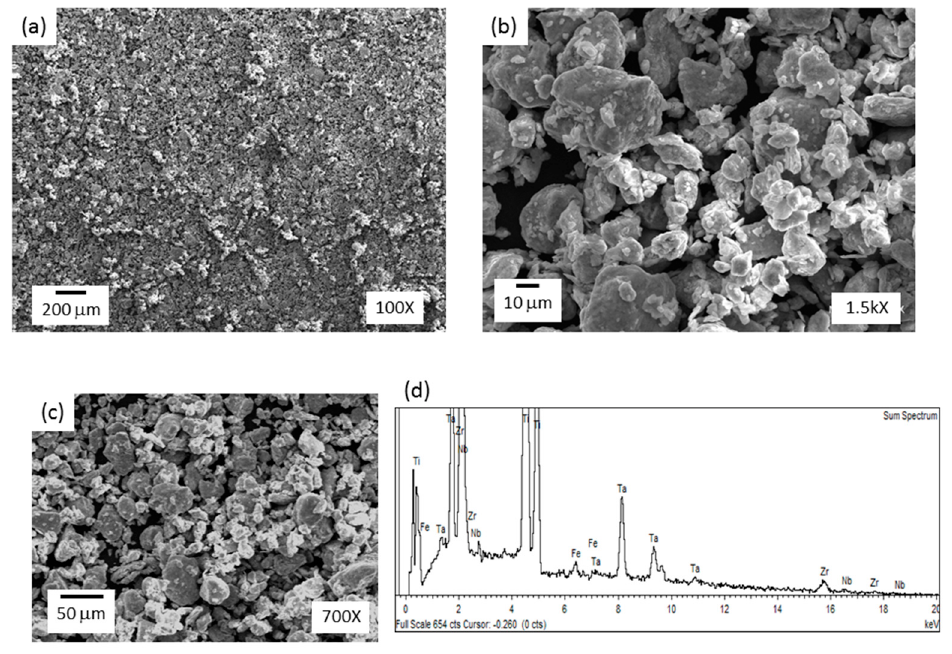
Figure 4. SEM images of milled Ti-13Zr-13Ta-3Nb powders and corresponding EDS analysis.